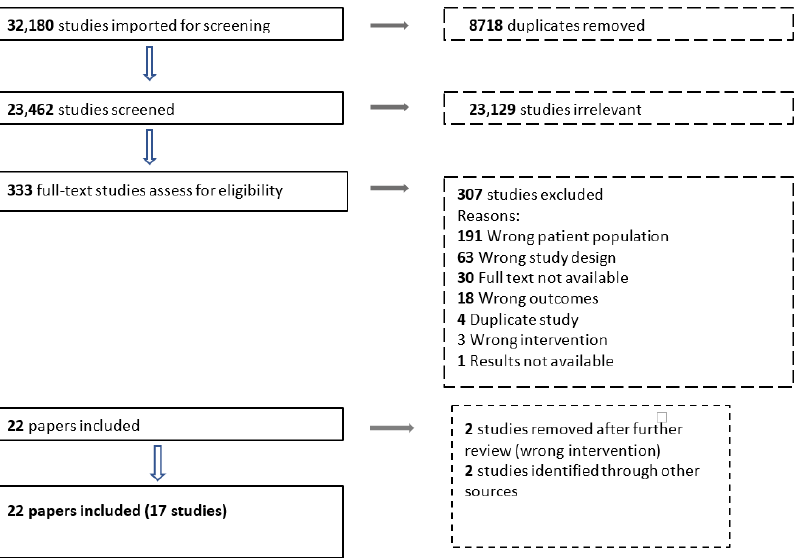
Figure 3. PRISMA flow diagram.